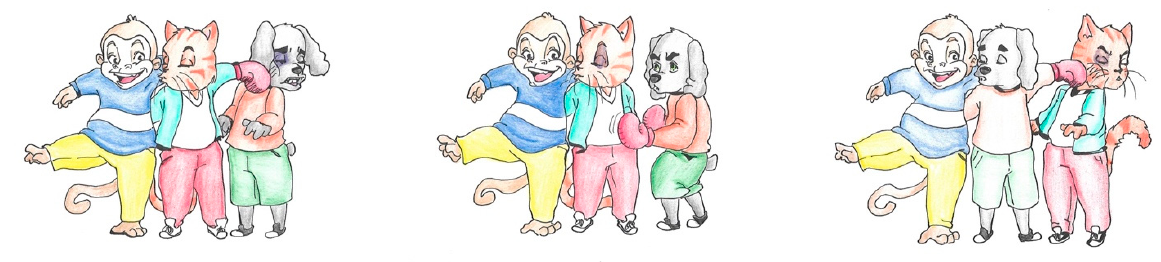
Figure A7. SRC stimulus 2.